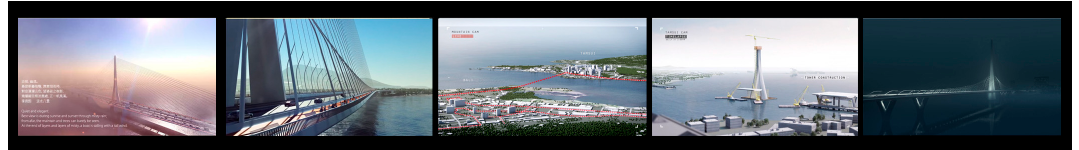
Figure 11. Hadid, Danjiang Bridge, Taipei. Movie by MIR (Bergen, Norway) (4:44),